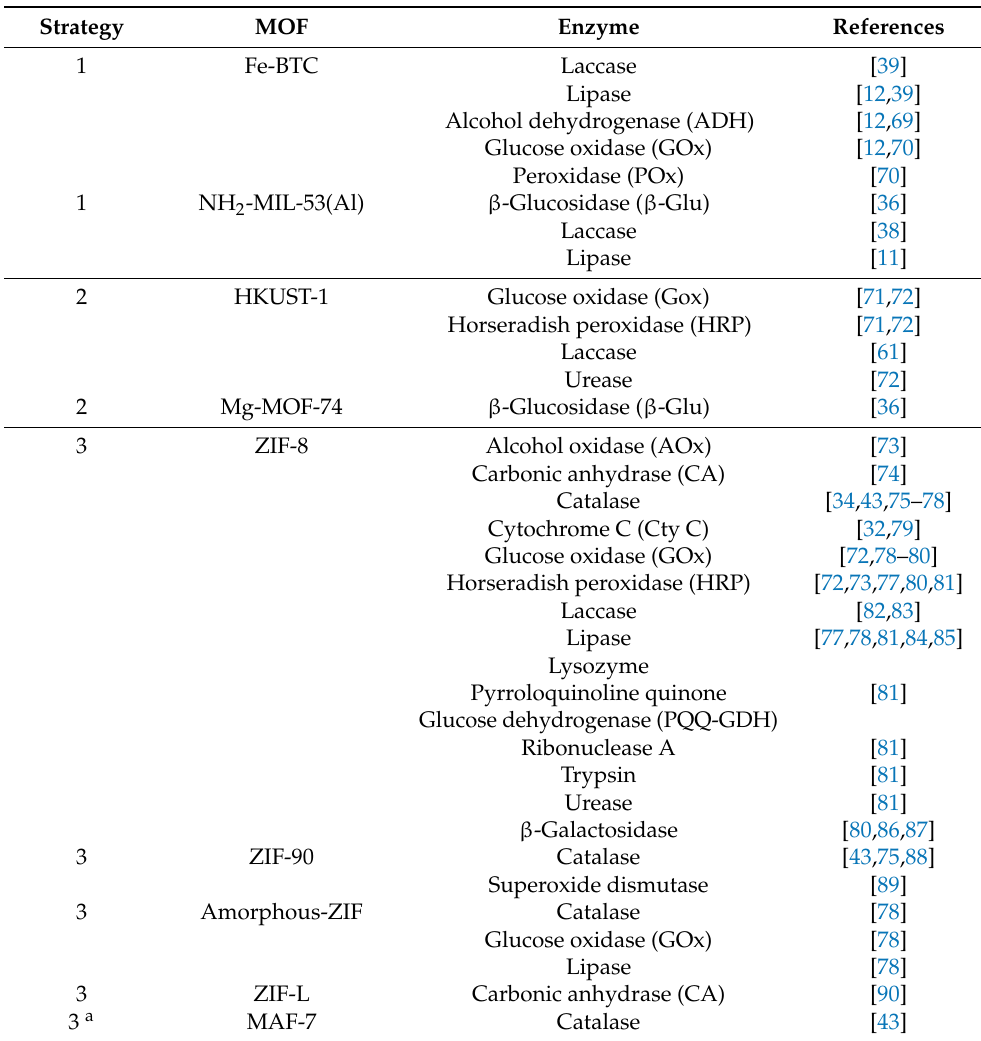
Table 2. Summary of the strategies, MOF supports, enzymes and biocomposite Enzyme@MOFs covered in this work. The number used for denoting the different strategies is in accordance with those used in Scheme